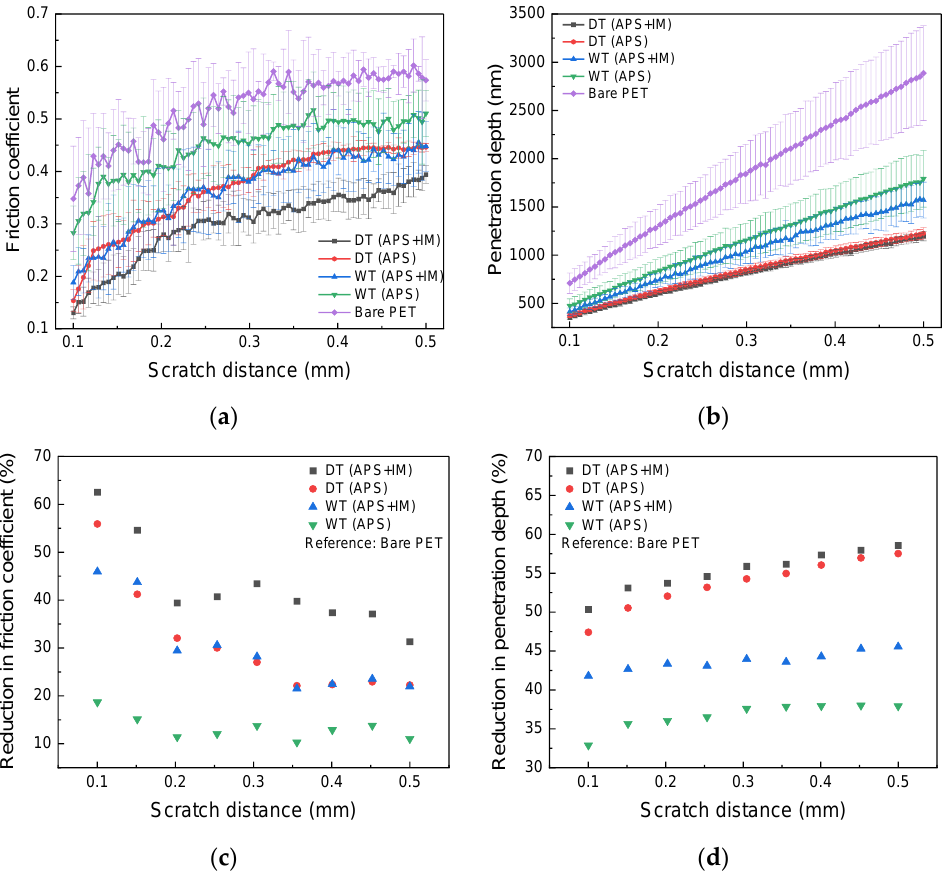
Figure 4. Frictional and wear resistance properties of the Gr/PET films and the bare PET substrate as a function of scratch distance. ( a ) Friction coefficient, ( b ) penetration depth, and reduction ratios in ( c ) the friction coefficient and ( d ) penetration depth with respect to the bare PET.